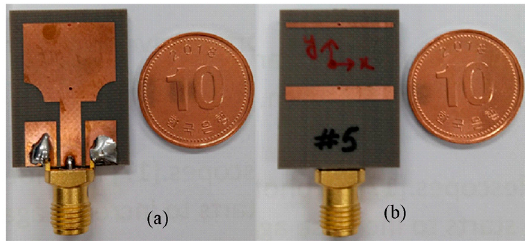
Figure 13. Photo of fabricated UWB antenna with rectangular notched band: ( a ) front side ( b ) back side.